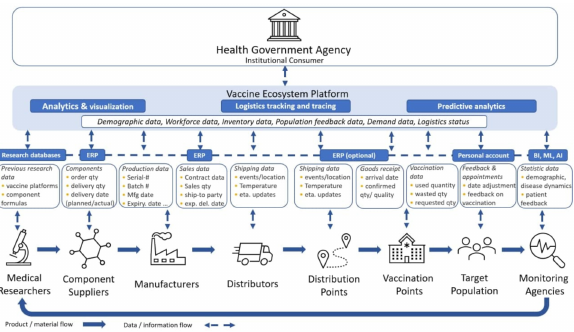
Figure 6. Vaccine ecosystem: platform application and data architecture